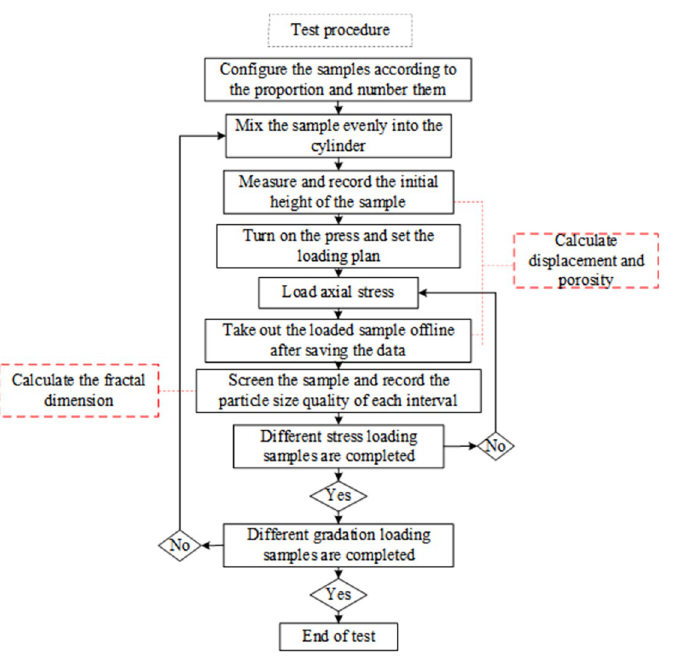
Fig 3. Test flow chart.